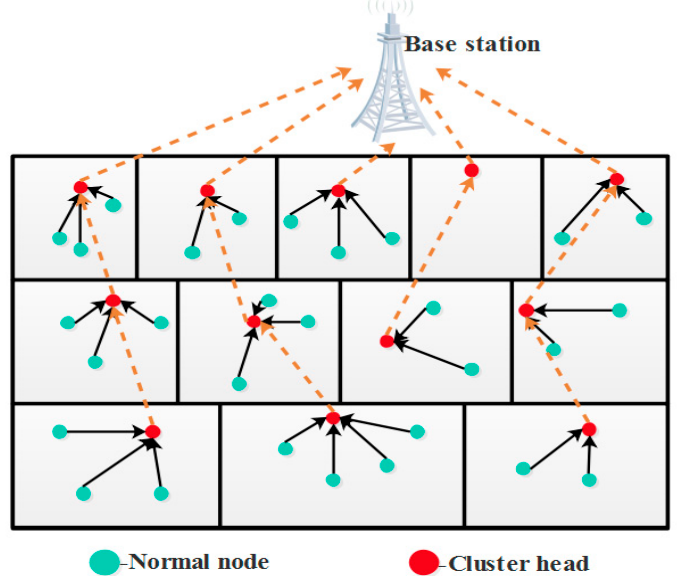
Figure 1. Proposed multi-tier framework.